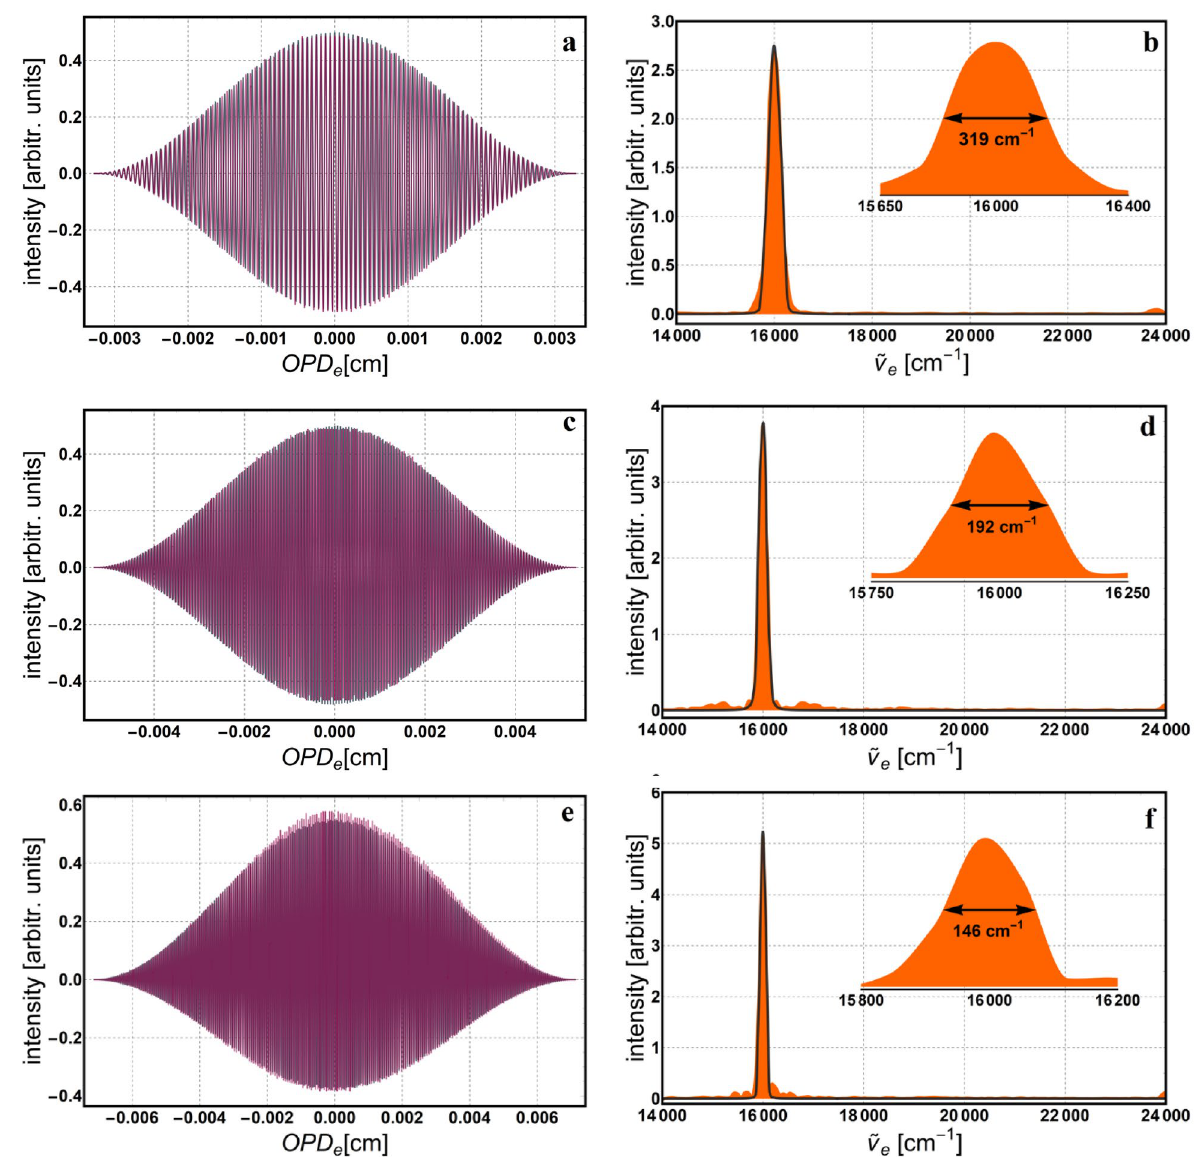
Figure 4. Simulation (gray) and experimental (color) reconstruction of both, apodized interferogram and the corresponding monochromatic spectrum for the 625 nm source: ( a , b ) 512; ( c , d ) 1024 and ( e , f ) 2048 data points. Insets show the enlarged area around the peak, with the corresponding spectral width value computed as the Notice, there are only two interferograms (Fig. 4a,c) that are symmetric around the average value, y = 0. Usu- ally, if there are no losses within the optical components or stray reflections, they all should be symmetric. In our case, the anomaly is due to the sensitivity of the detector, which can be approximated by the sigmoid logistic func- tion. Hence, for the two symmetric cases, the intensity minimum and maximum values in the interference image, were situated on the linear middle part of this sensitivity curve. For the rest of the interference images, where the overall intensity was lower, it seems the minimum is situated on the lower part of the curve, where the gain in volt- age is not linear but slightly higher; hence the asymmetry around the mean value. The composition of individually measured spectra of the same light sources but taken with a commercial spectrometer (ARCspectro HT-HR) 36 is µ) 2 / 2 σ 2 ( x c , where a exp depicted in Fig. 7a, together with their corresponding Gaussian fittings, y − + = − a and c are constants, μ is the mean value and σ is the standard deviation. Following these fittings, the mean and (cid:31) (cid:30) 1 21026.9cm 163.6 16025 cm − 1 , µ G 18820cm − 1 , µ B standard deviation get the next values: µ R , σ R − = = = = 391.3 cm -1 and σ B 436.9 cm -1 . For comparison, the spectra for 512 data points and Gaussian fit- cm -1 , σ G = = tings of the spectra recorded with the commercial spectrometer are shown in Fig. 7b. Notice the mean value of each peak varies slowly from the central value (i.e., 16,000 cm −1 —red LED, 18,867 cm −1 —green LED and 21,052 cm −1 —blue LED) and the standard deviation is larger, especially for the blue and green LEDs. In order to quantize the difference between these spectra, we used the ratio of the corresponding variances and obtained the